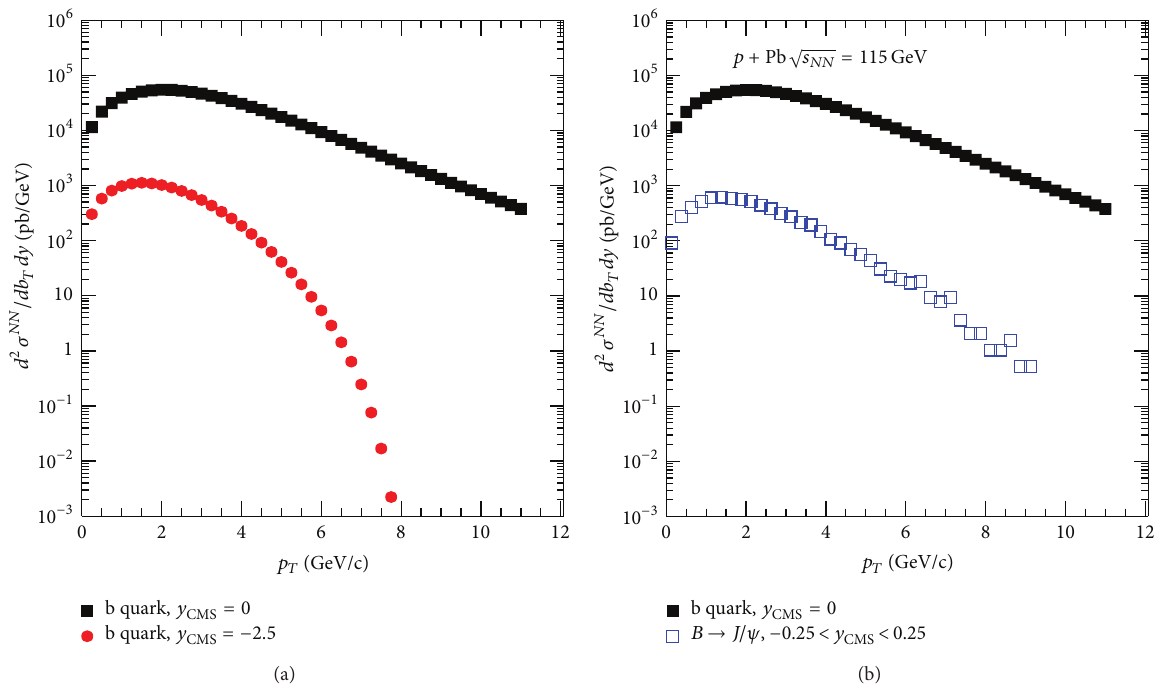
Figure 4: Bottom quark differential cross section per nucleon-nucleon collision as a function of 𝑝 𝑇 in 𝑝 + Pb collisions.